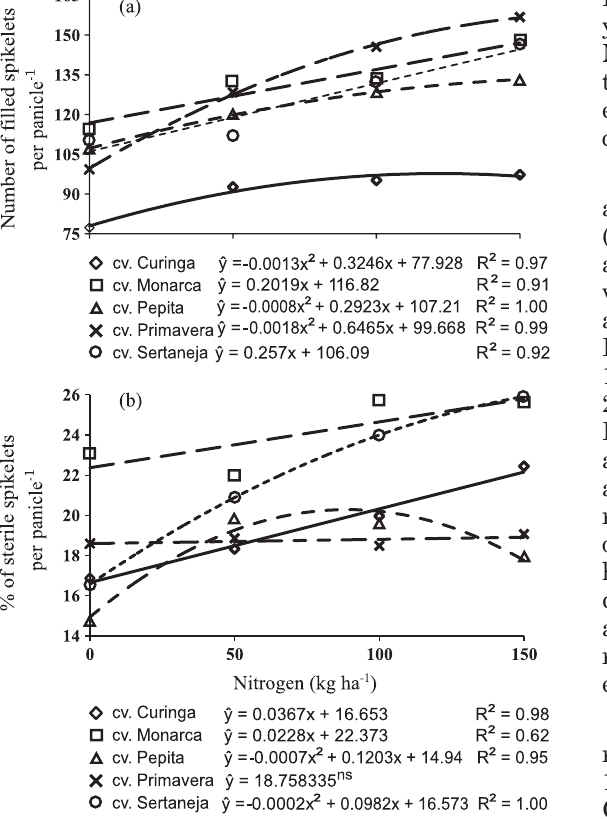
%.figure 4. number of filled grains per panicle (a) and percentage of sterile spikelets per panicle (b) of rice cultivars as a function of n